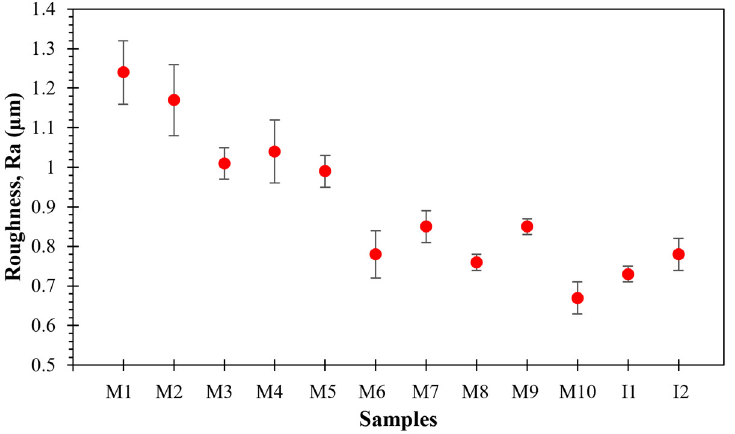
Figure 4. Average roughness ( Ra ) values retrieved from the surface of obtained sintered nanocom- posites.